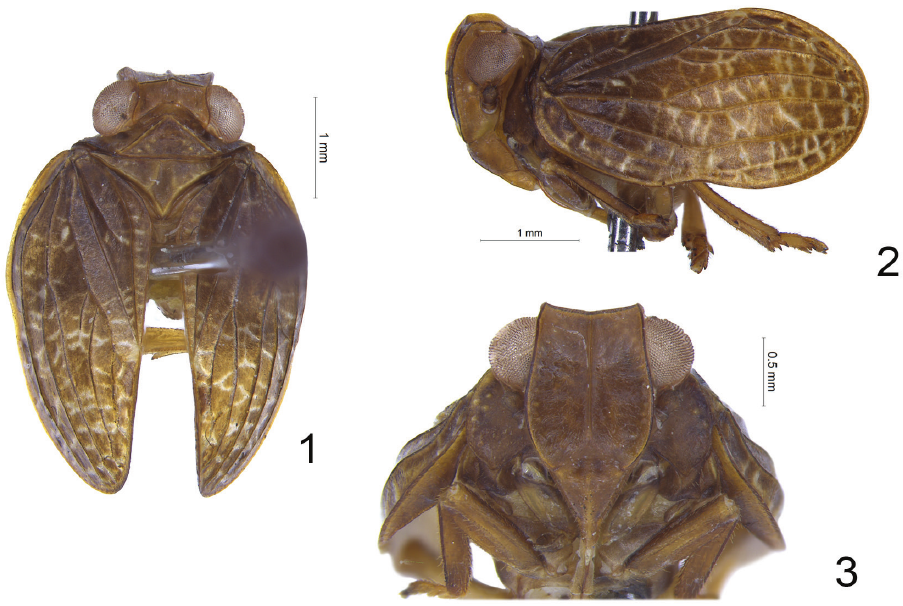
Figures 1–3. Sinonissus brunetus sp. n., holotype. 1 Adult, dorsal view 2 Adult, lateral view 3 Adult, ventral